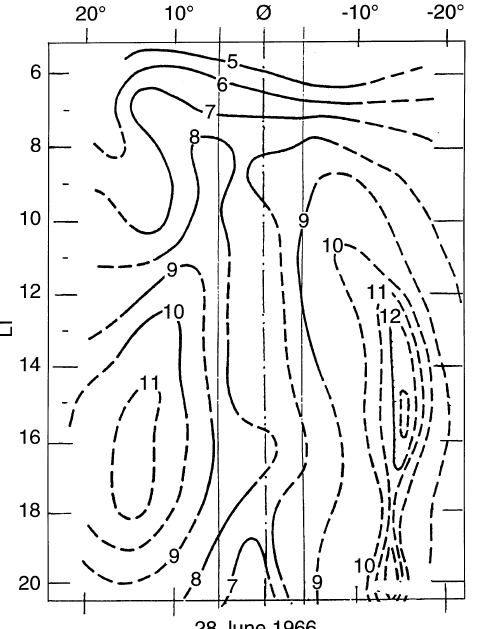
Fig. 3. Schematic morphologies – upper row : three trough-like types; bottom row : frame c for morning northern crest, frame d for morning trough and afternoon dometype, frame e for magnetic field- perpendicular gradient (November to